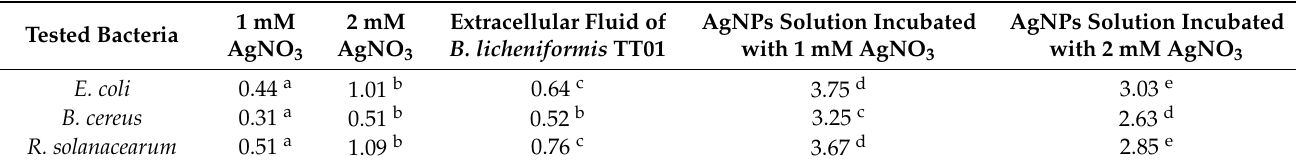
Table 2. The diameters of antibacterial zones (cm) against various bacterial strains generated by various samples: 1 mM AgNO 3 , 2 mM AgNO 3 , extracellular solution of B. licheniformis TT01 and AgNP solutions obtained in process B. Tested